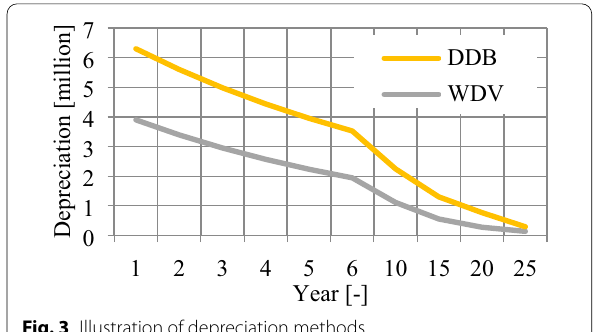
Fig. 2 Total cost, operating cost and revenues (million) for AVS Ltd Fig. 3 Illustration of depreciation